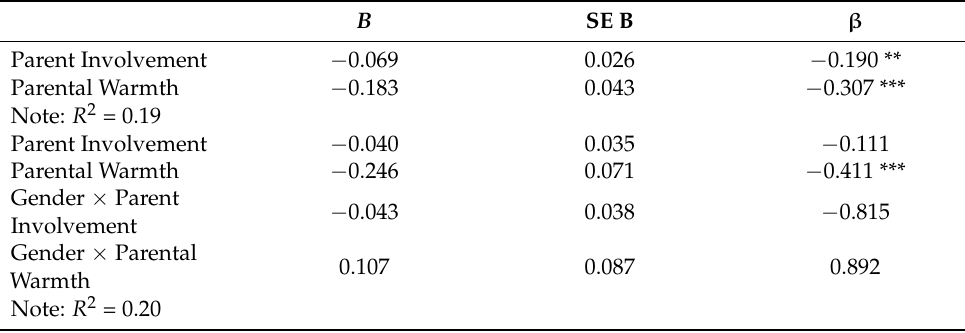
Table 8. Regression with moderators—behavior